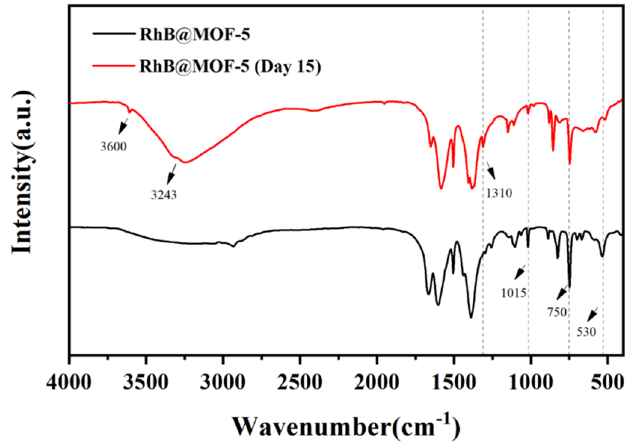
Figure 4. FT-IR spectra of RhB@MOF-5 response to pork deterioration.